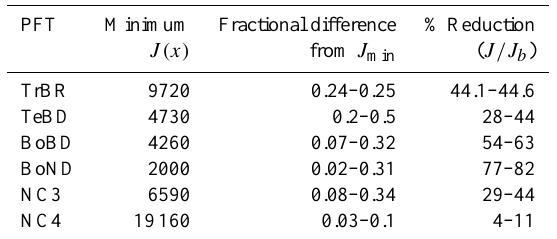
Table 3. Metrics to describe the ability of the optimisation algo- rithm to find the global minimum of the cost function for the MS op- timisation using 20 different random “first guess” parameters. The 2nd column shows the final value (after 25 iterations of the BFGS optimiser) for the random test that resulted in the lowest value of J(x) (the cost function), which corresponds to the highest % reduc- tion in J(x). The 3rd column gives an indication of the distribution of the final values for all 20 tests with respect to the lowest value ob- tained (given in column 1). This is represented as the difference be- tween the final value of J(x) for each test and the minimum value of J(x) , divided by the same minimum value. The 4th column shows the % reduction of J(x) normalised to the value of J(x) for the de- fault parameters of ORCHIDEE. The two values for the 3rd and 4th columns represent the interquartile range (25th to 75th percentiles) for the spread across the 20 random tests.